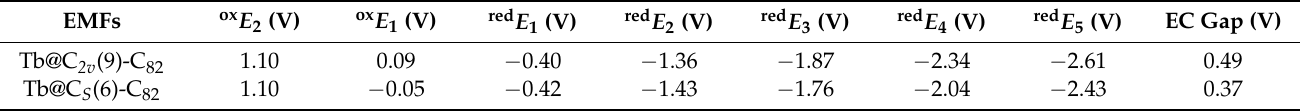
Figure 8. CV curves of ( a ) Tb@C 2v (9)-C 82 and ( b ) Tb@C S (6)-C 82 isomers. Conditions: working electrode, platinum plate; counter electrode, platinum plate; reference electrode, Ag wire; supporting electrolyte, 0.05 M n-Bu 4 NPF 6 in o-dichlorobenzene; scan rate, 20 mV/s. Table 1. Redox Potentials (V vs. Fc/Fc + ) a of Tb@C 2v (9)-C 82 and Tb@C S (6)-C 82 EMFs